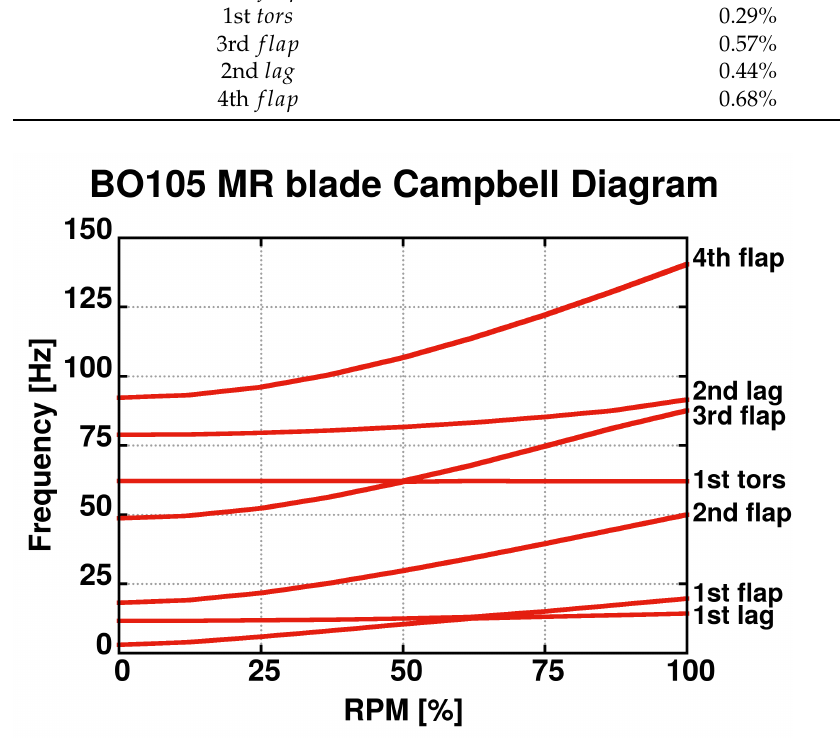
Figure 33. Campbell diagram of BO105 MR.